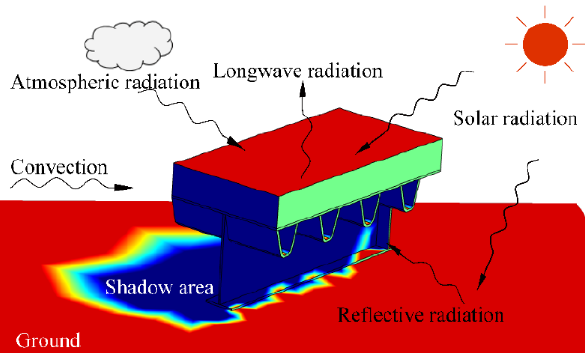
Figure 10. Mechanisms of heat transfer.